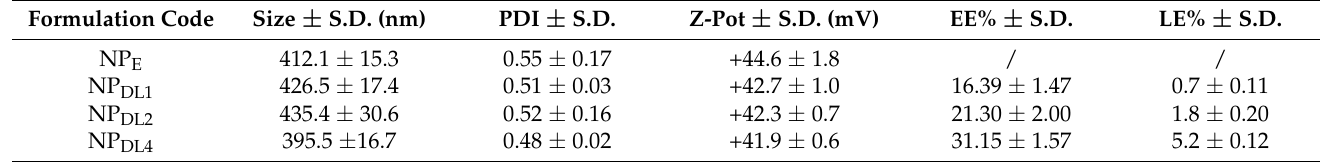
Table 5. Properties of CS NPs in terms of mean size, polydispersity index (PDI), Zeta potential, encapsulation efficiency (EE%), and loading efficiency (LE%) (see Table 4 for CS NPs composition). Formulation